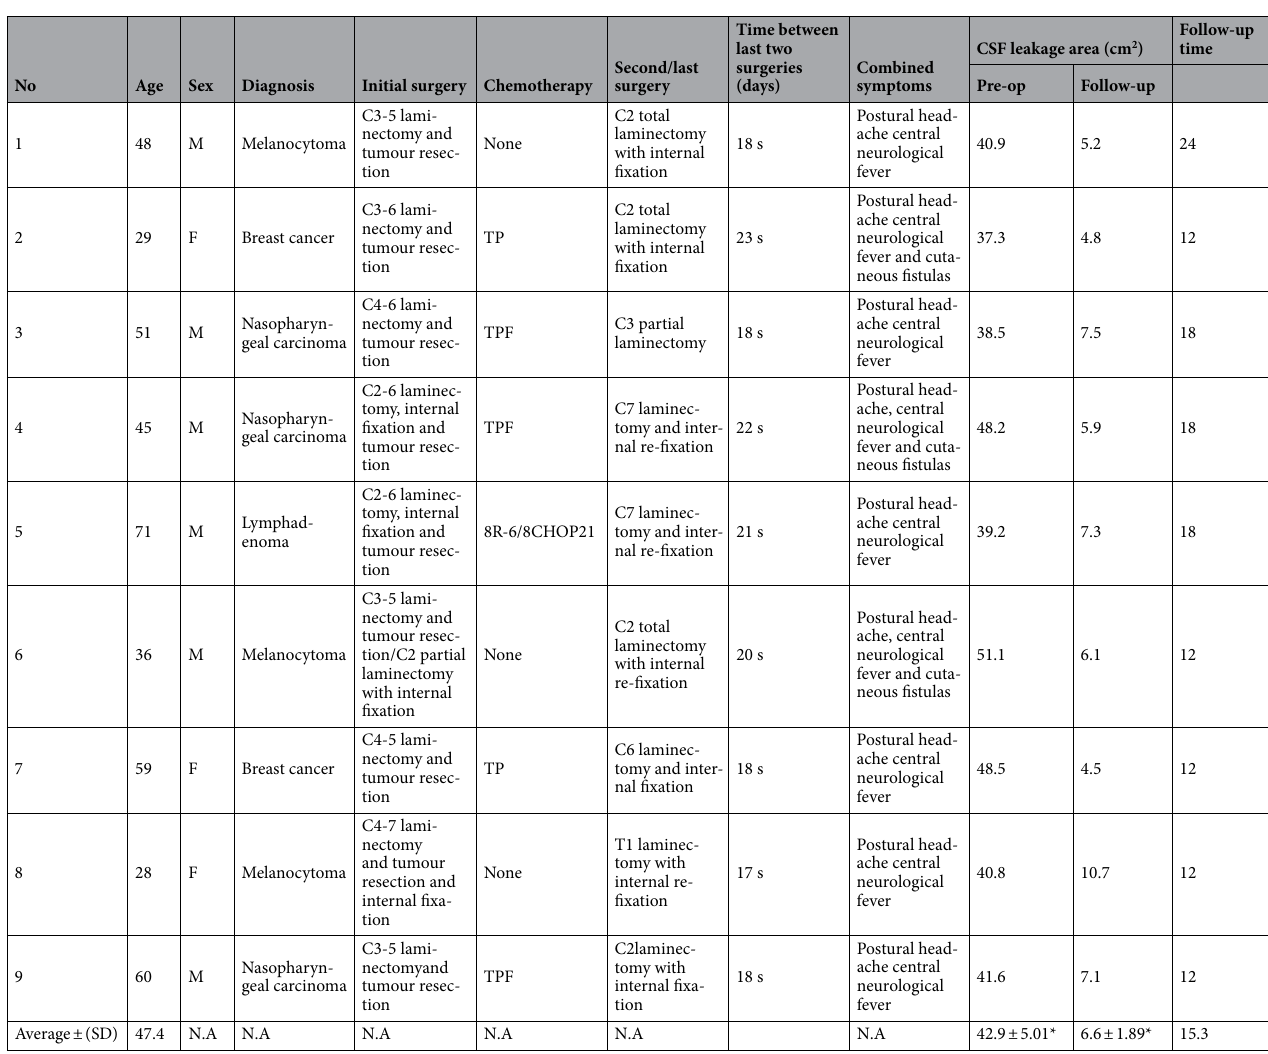
Table 1. Patient demographics. *There was a significant difference between these two measurements, P <